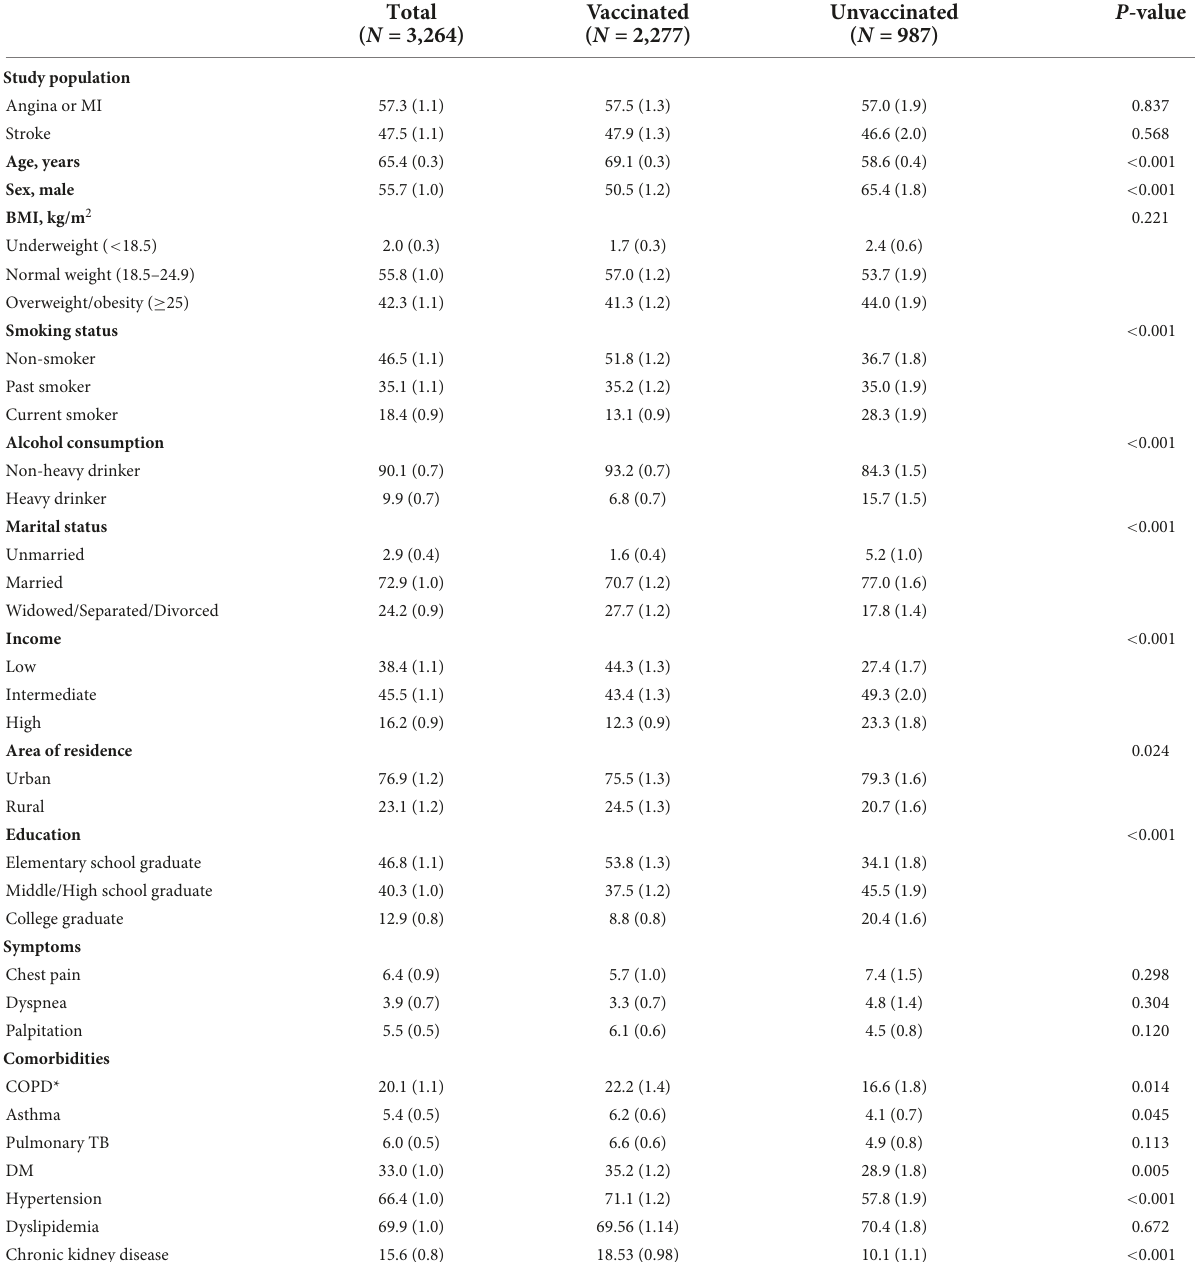
TABLE 1 Baseline characteristics of the study population.